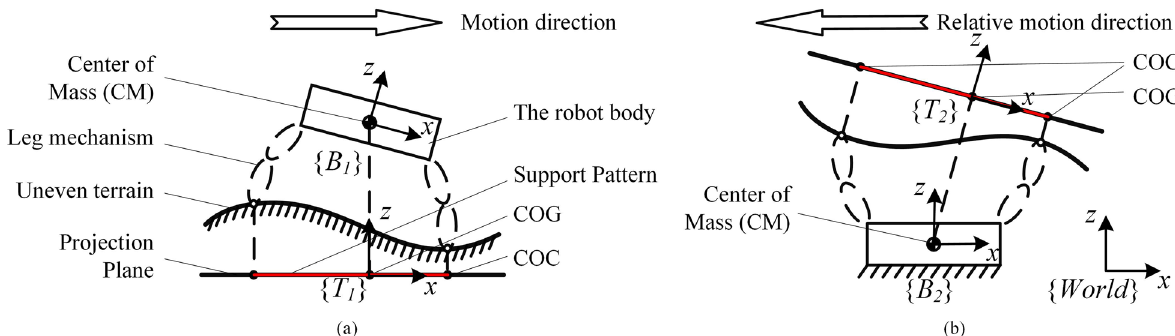
Figure 1 Schematic diagram of Inverted Modelling in sagittal plane: a motion model of quadruped robot on uneven terrain, b Inverted Modelling of quadruped robot on uneven